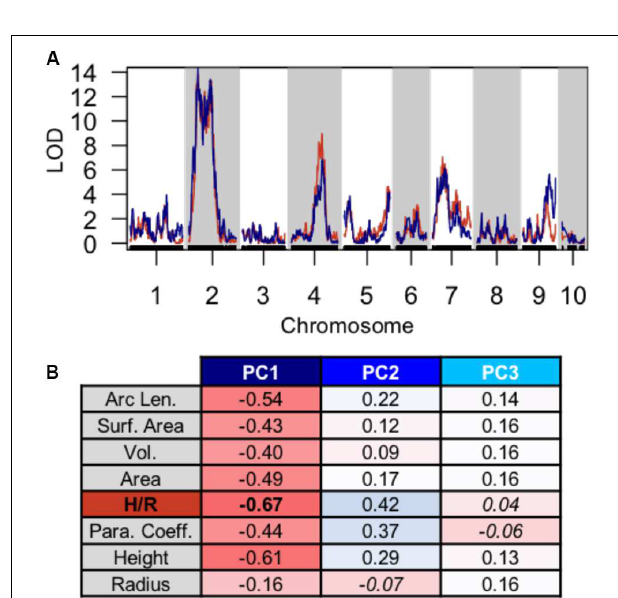
FIGURE 5 | Discreet cosine transform PC1 recaptures QTL and phenotypic variation identified by parabolic estimators. (A) Close overlap of QTL identified using PC1 (blue) and H/R (red). (B) Strong pearson correlation (r) between PC1 and several parabolic estimator phenotypes. Correlation value, red to blue. Non-significant correlation Fischer transformation P > 0.05,